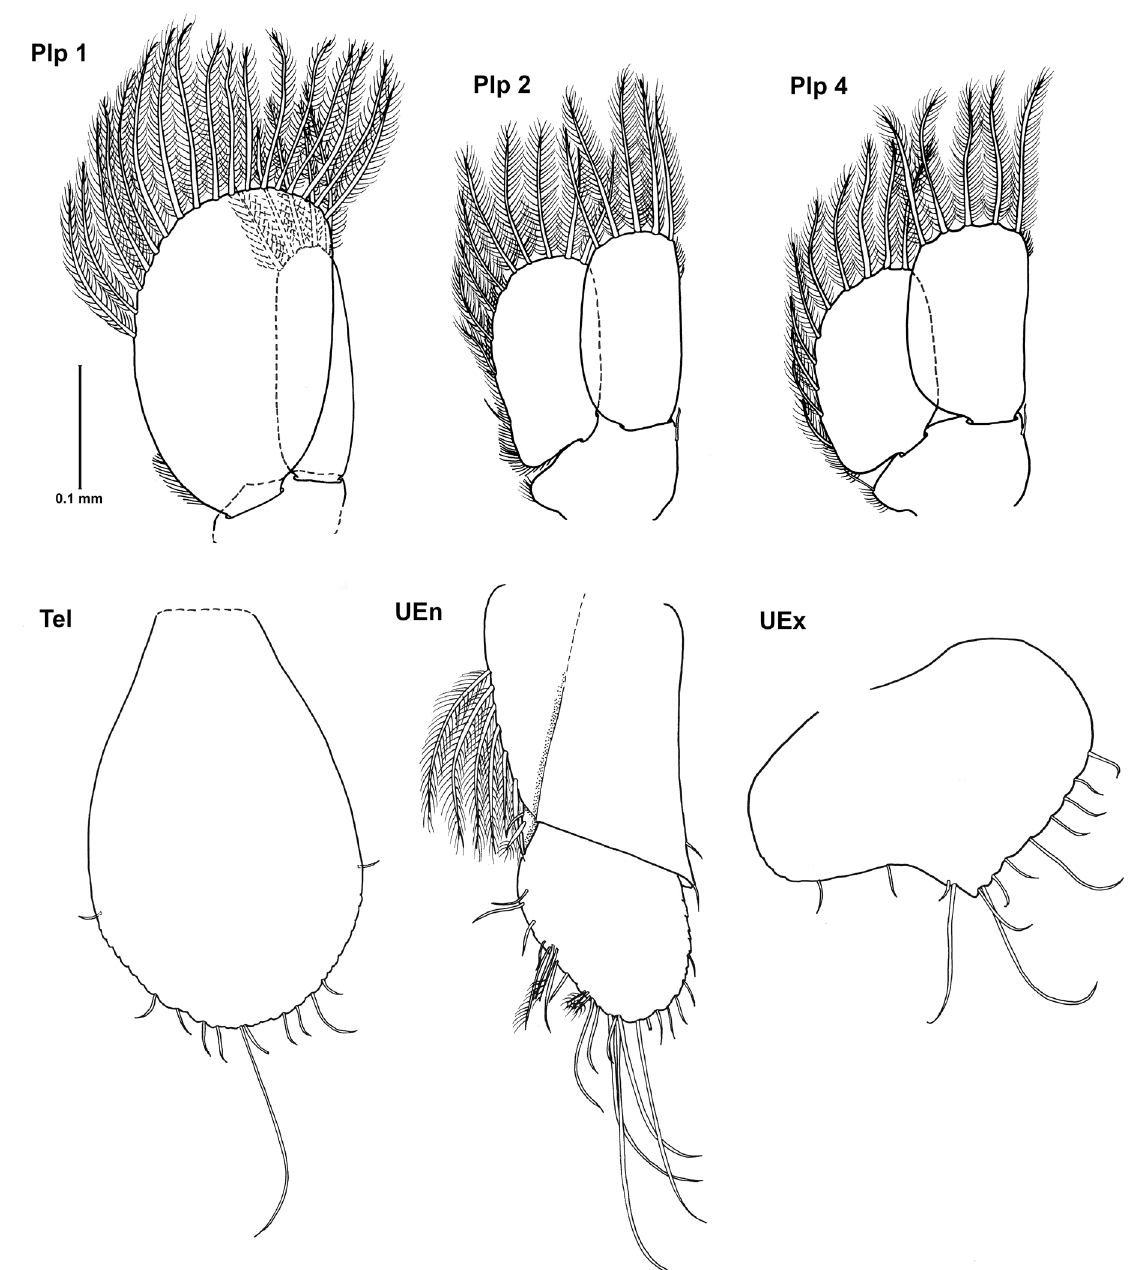
Fig. 26. Expanathura marcoi sp. nov., ♀, holotype (MZB Iso 108) . Abbreviations: Plp1–Plp4 = pleopods 1–4; UEx = exopod of uropod; UEn = endopod of uropod; Tel =